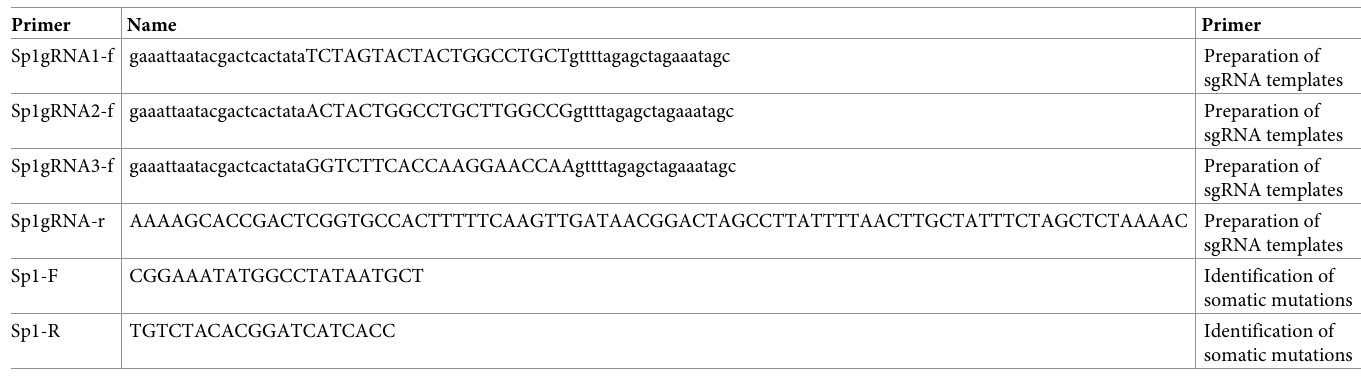
Table 2. Primers used in this study.